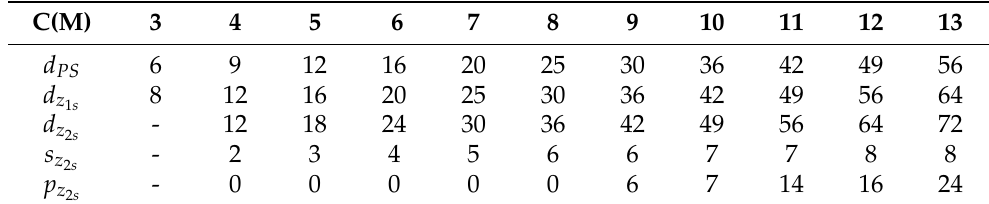
Table 3. Maximum available approximation order for a cost C using the Paterson–Stockmeyer method, order denoted by d PS , maximum order using z 1 ps from (19) combining (16) and (17) with the Paterson–Stockmeyer, denoted by d z , and maximum order using z 2 ps from (19) combining (66) 1 s with the Paterson–Stockmeyer method, denoted by d z , whenever a solution for the coefficients of 2 s z 2 ps exist. Parameters s and p for z 2 ps ( x ) such that s is minimum to obtain the required order giving a system (89) of s equations with minimum